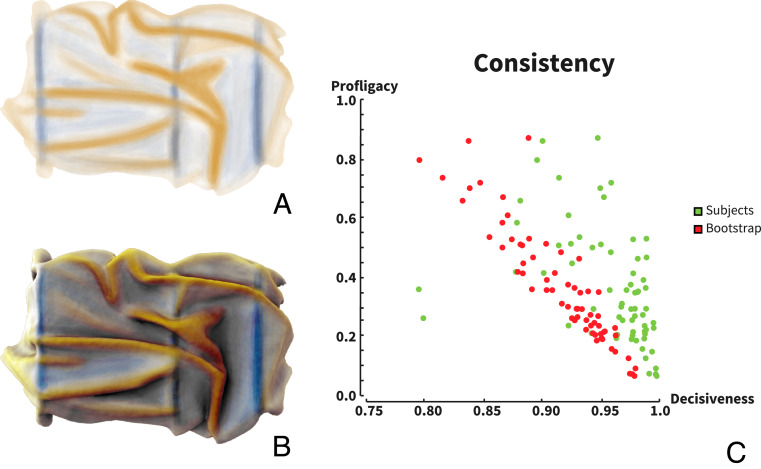
(A) Experiment 2: mean responses from 68 participants on stimulus C5. Blue indicates contact; yellow indicates fabric. (B) Data superimposed on the original image (see SI Appendix, Fig. S2 for all stimuli). (C) Profligacy and decisiveness of participants’ responses (see Materials and Methods for definitions). Green dots indicate responses for individual participants. Red dots indicate results of bootstrapping with random responses, statistically matched to individual participant data.